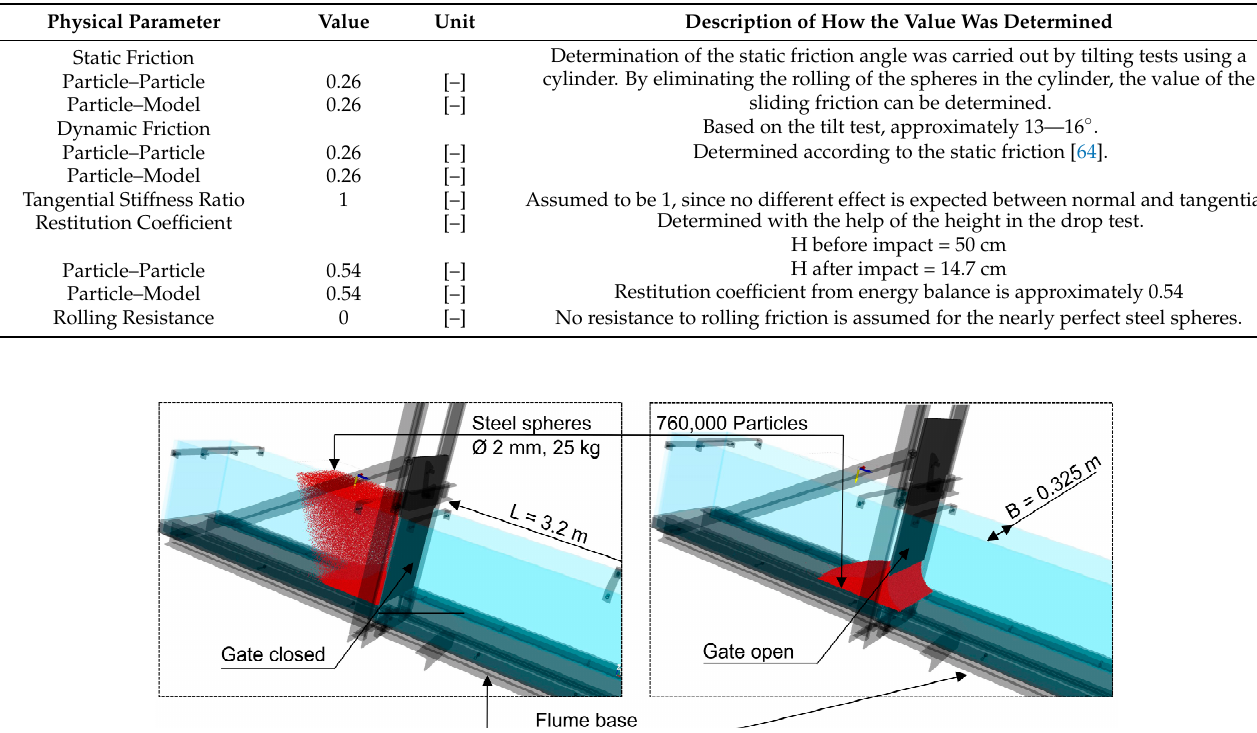
Table 7. Friction and restitution coefficients between the particle and particle model test used for DEM simulation. The column on the right describes the results of the laboratory test for the test material.